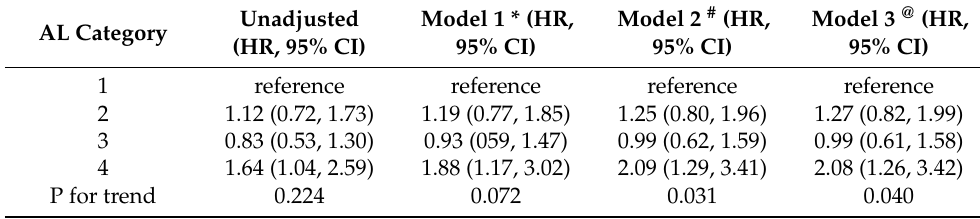
Table 4. Associations between AL category and overall cancer